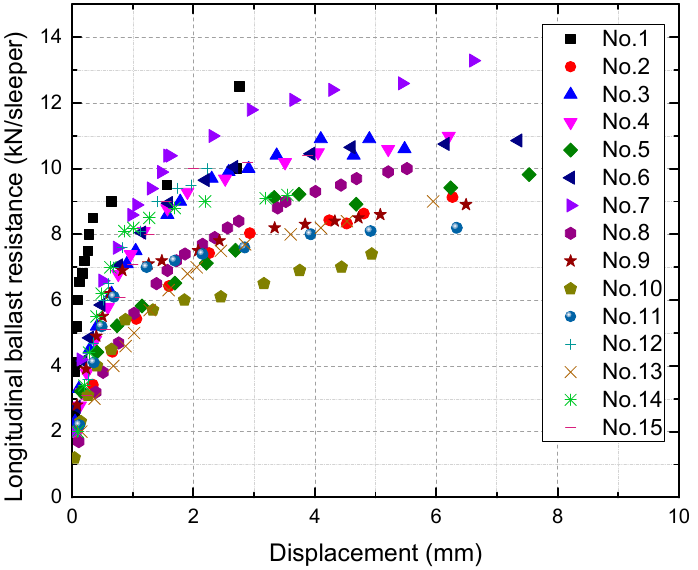
Figure 6. Lateral ballast resistance versus displacement.